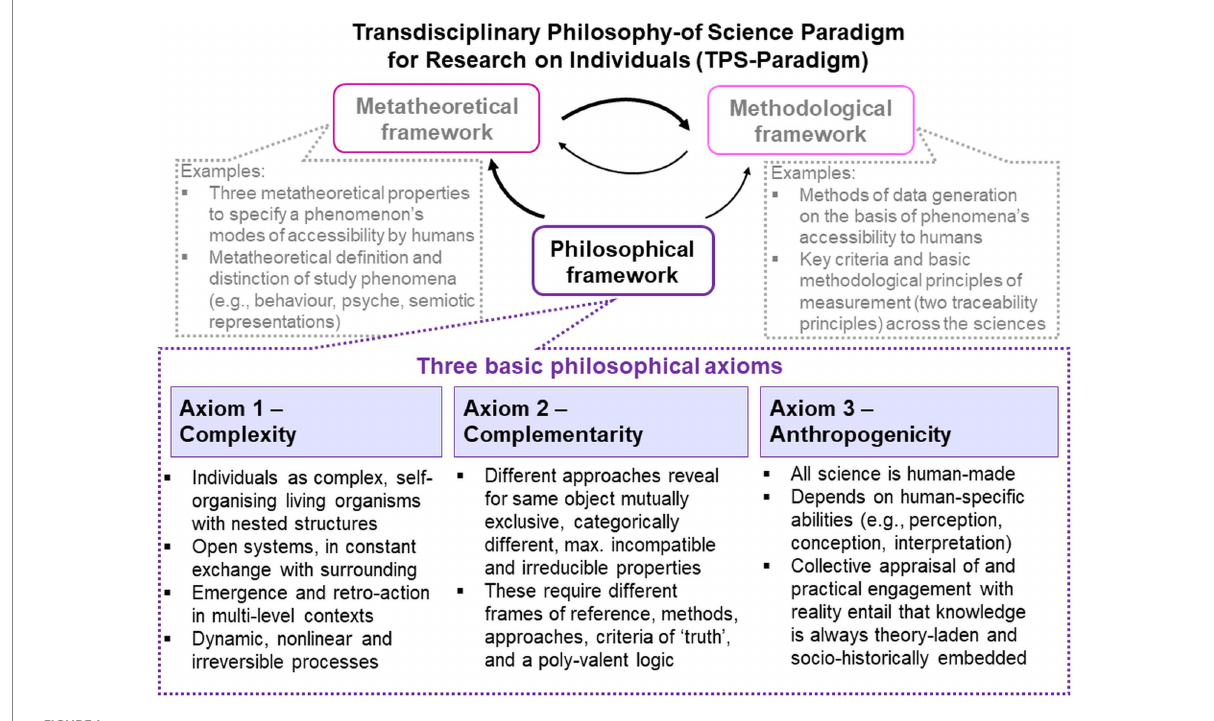
FIGURE 1 The TPS-Paradigm with its interrelated frameworks and three basic philosophical